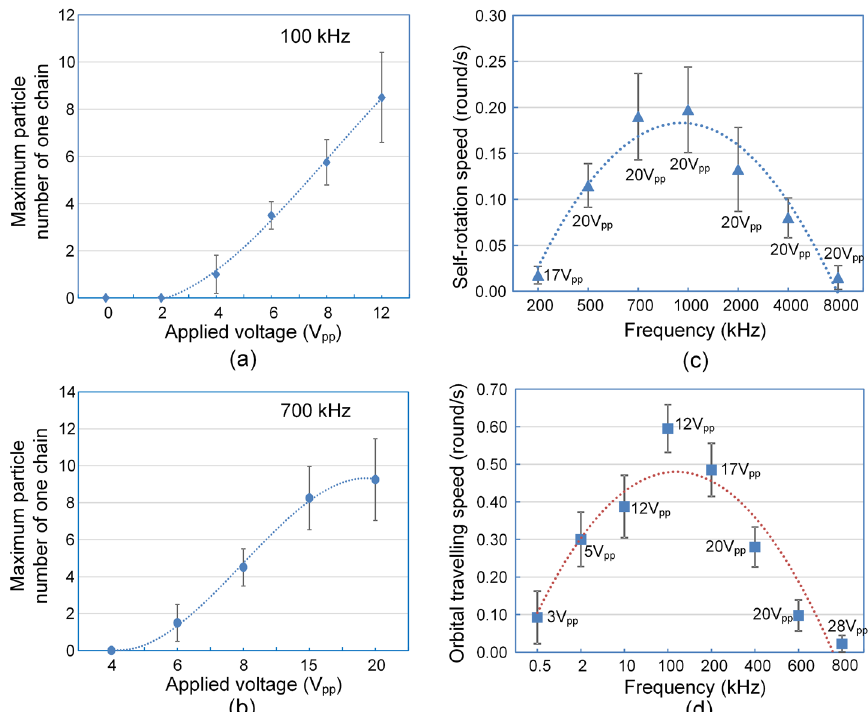
Figure 9. The quantitative study on the particle chain length, self-rotation and orbital movement of microparticle chains. ( a – b ) Dependence of the maximum particle number of self-assembled particle chain on the applied voltage at 100 and 700 kHz. ( c ) Dependence of self-rotation speed of particle chain on the frequency. ( d ) Dependence of orbital movement speed of particle chains on the frequency. The applied voltages are smaller at lower frequencies for avoiding hydrolysis. The microparticles in these measurements have a diameter of 4 μm. The data points in each figure are fitted by second-order polynomial curves.